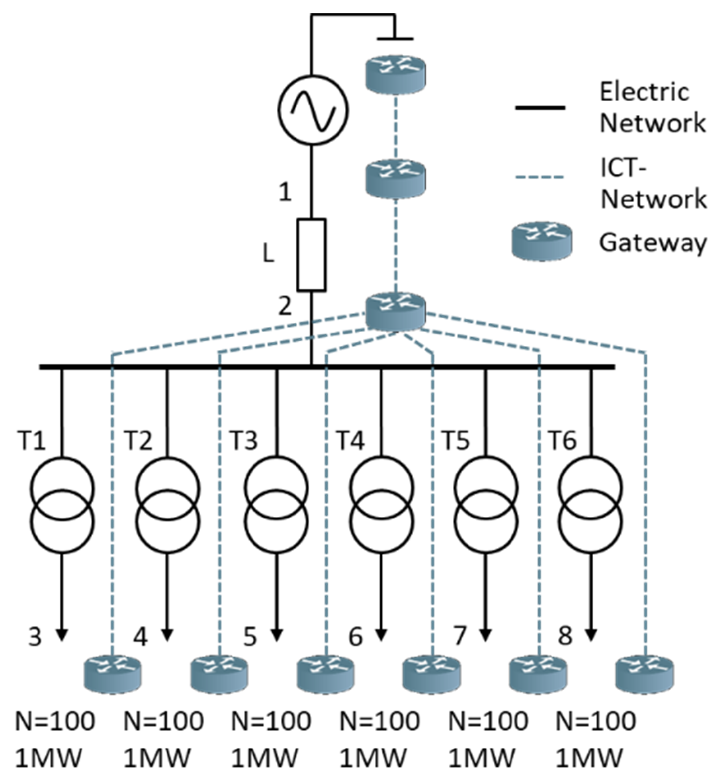
Figure A6. A proposed benchmark system for coupled electric power system and communications network (N—number of customers) (based on [80,81]).